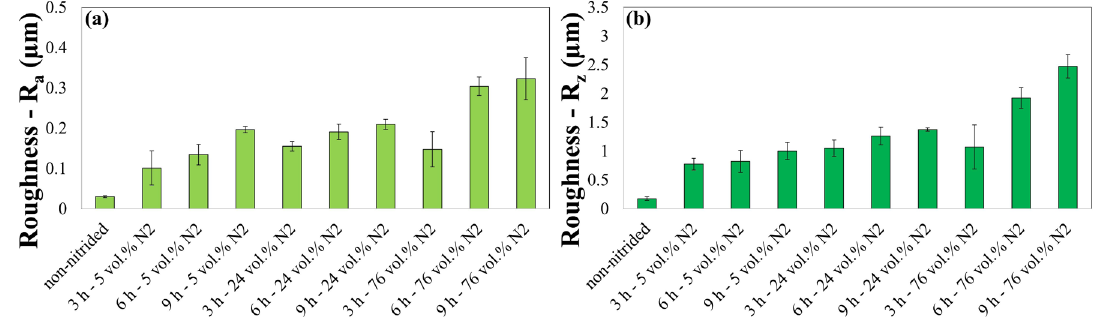
Figure 6. Roughness measurements in the non-nitrided samples and plasma nitrided samples with gas mixture composition of 76, 24, and 5 vol.% N : (a) R ; (b) R 2 a z